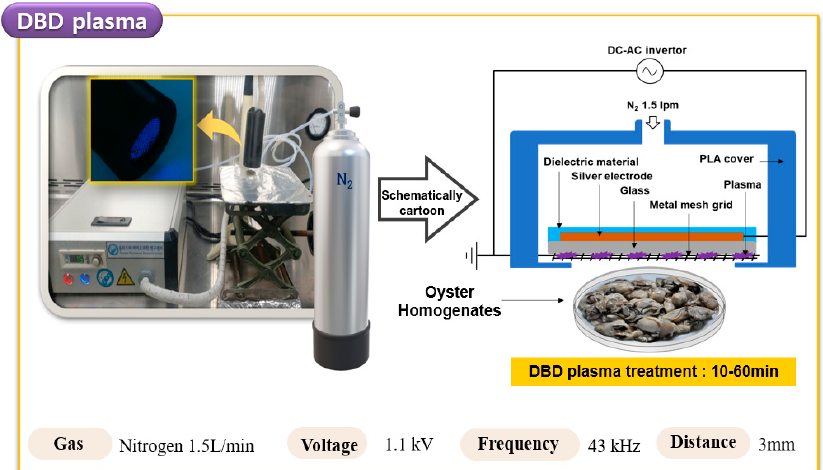
Figure 1. Schematic diagram of the dielectric barrier discharge (DBD) plasma system used for the oyster treatment. DC-AC, direct current and alternating current. PLA, polylactic acid.